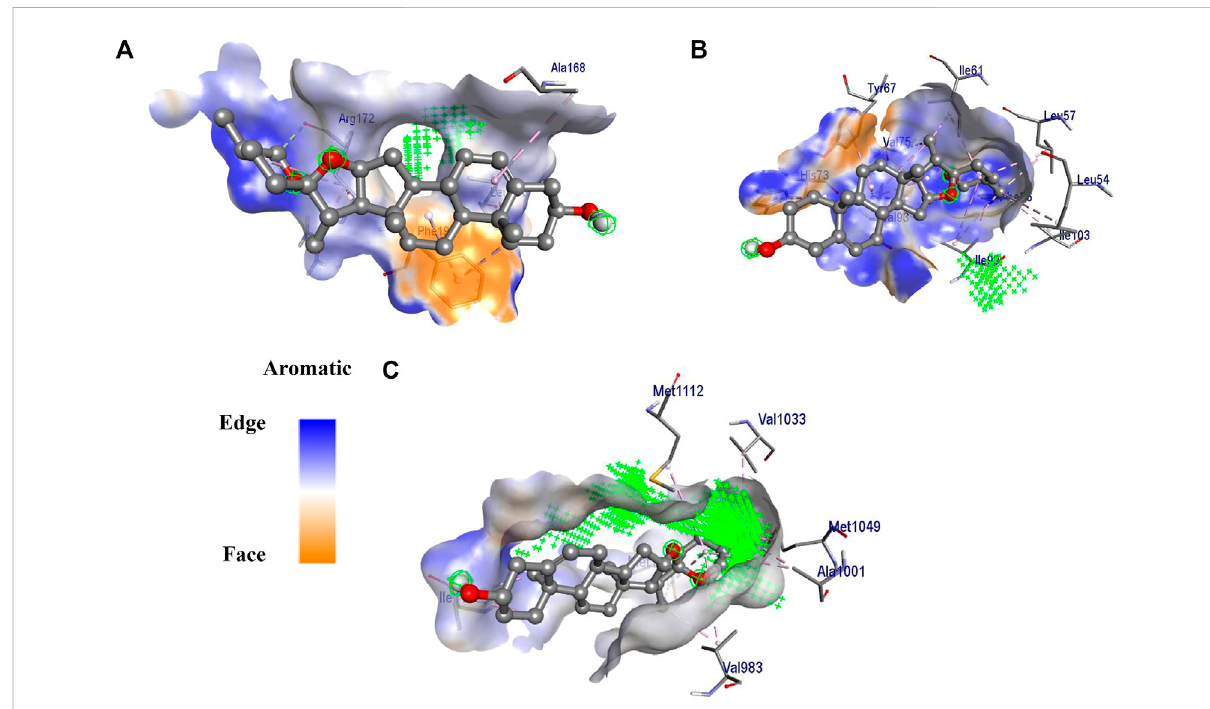
FIGURE 7 3D interaction of diosgenin with (A) SRC , (B) MDM2 and (C) IGF1R . The surface around the ligand presents an aromatic surface. The ligand was presented in ball and stick. Amino acid residues were presented on a stick and the active site of the protein was presented